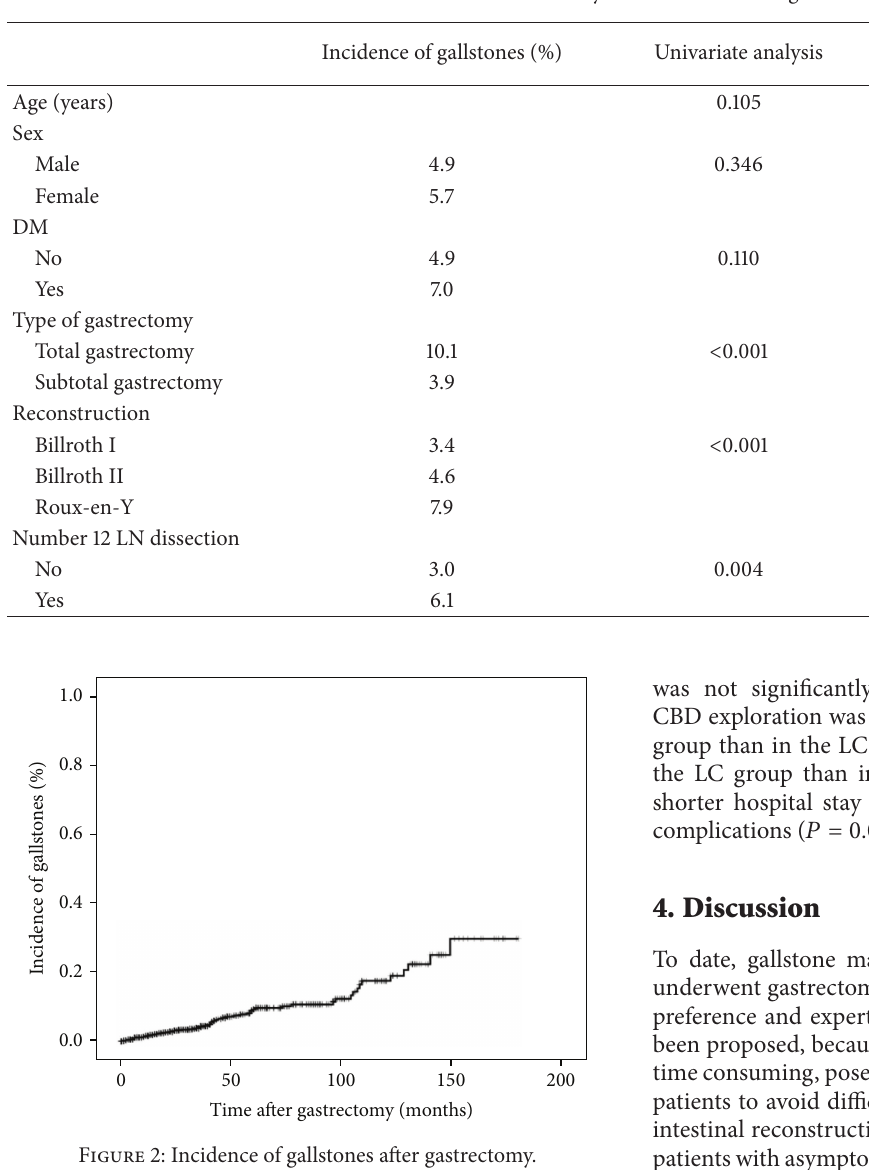
Table 2: Univariate and multivariate analysis of risk factors for gallstones after gastrectomy.